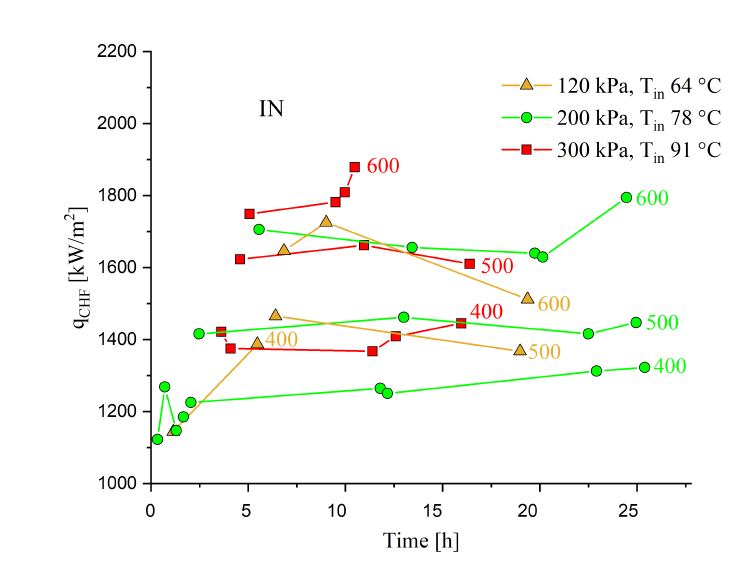
Figure 18. Measured CHF on smooth Inconel tube in different operation